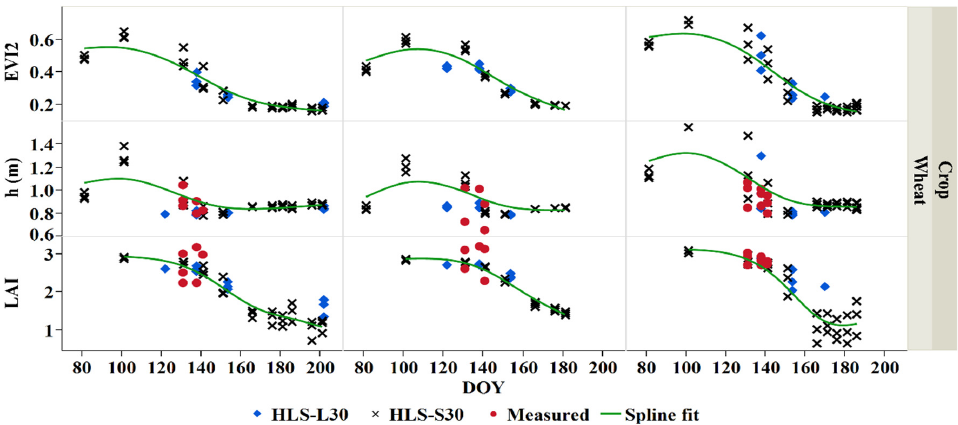
Figure 14. A combined L30 and S30 derived and measured biophysical parameters (EVI2, h, and LAI) time-series of wheat for three farms during the 2019 growing season, modeled (both L30 and S30) crop biophysical in green spline fit. Remote Sens. 2020 , 12 , x FOR PEER REVIEW 26 of 39